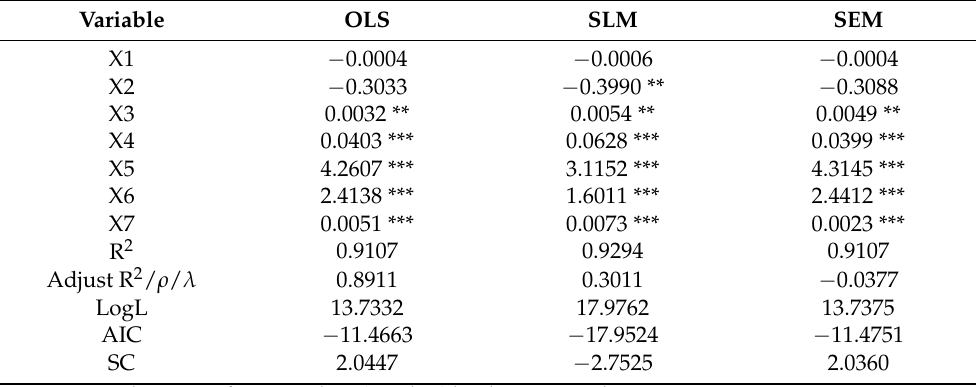
Table 4. Regression results of the spatial measurement model.